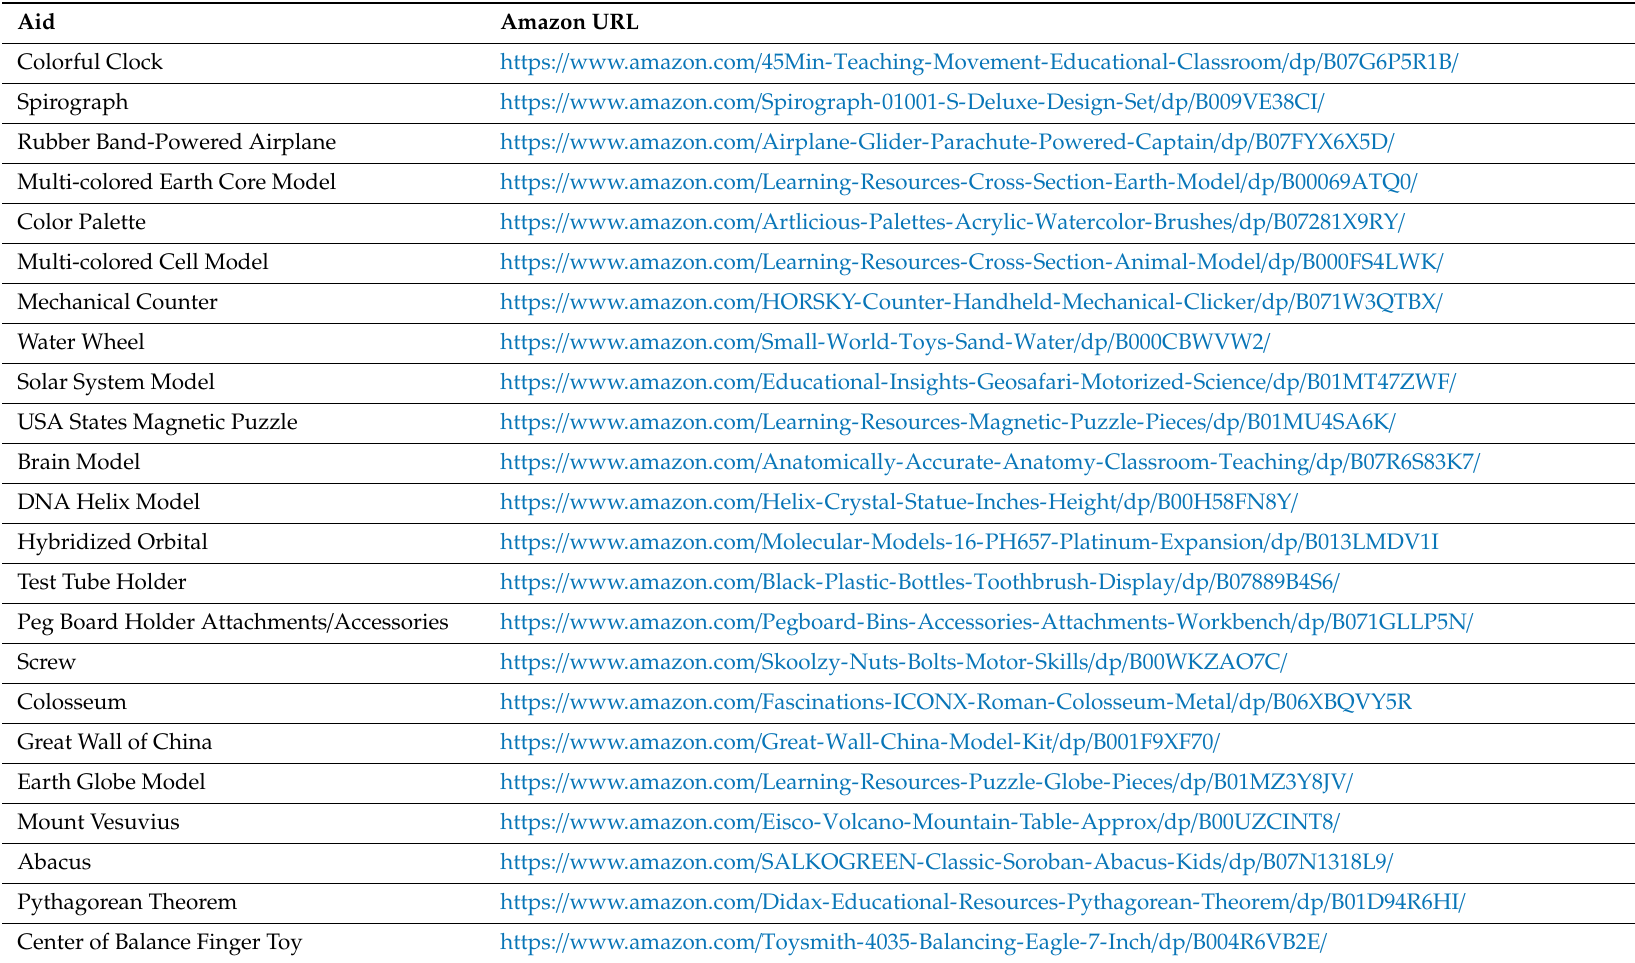
Table A2. Source file uniform resource locators (URLs) at